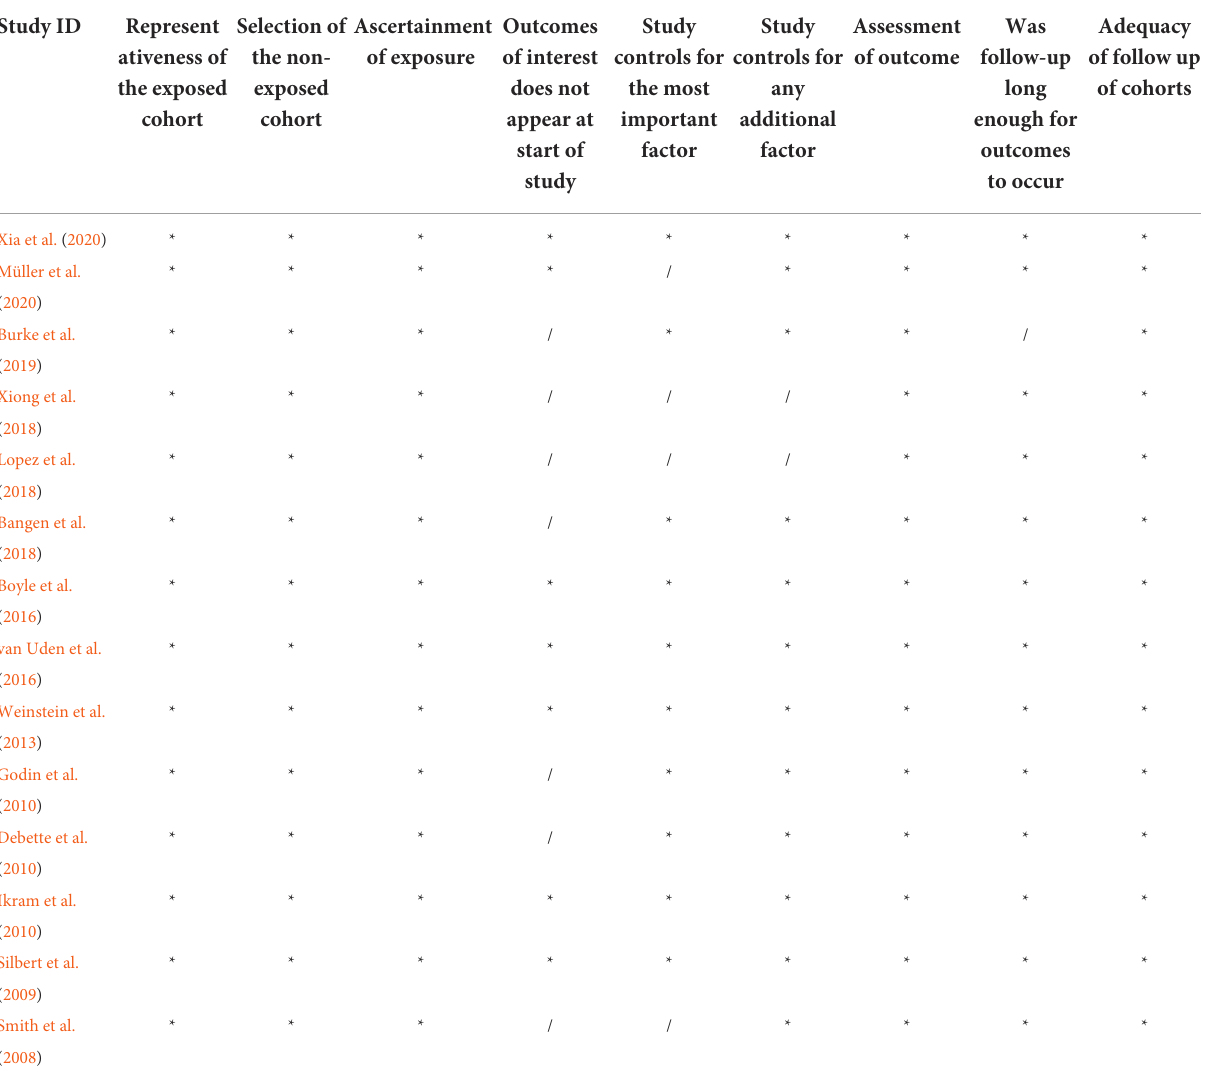
TABLE 1 Newcastle-Ottawa scale. Study